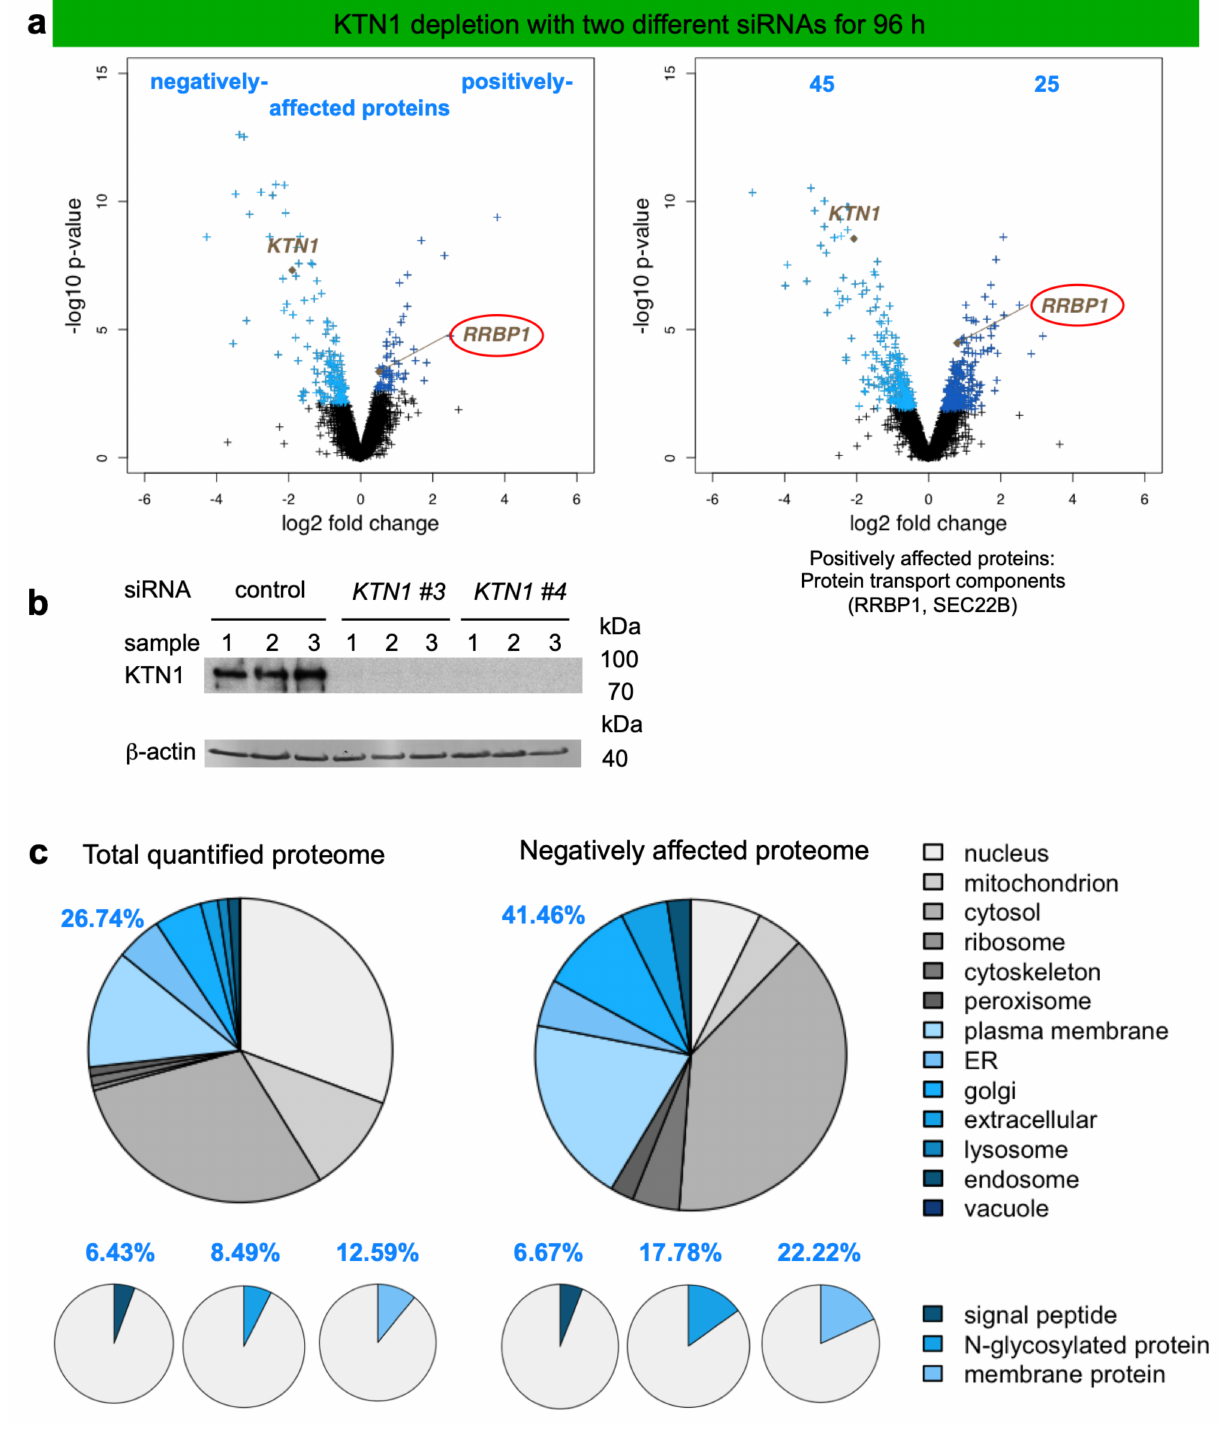
Figure 6. Volcano plots and GO enrichment after KTN1 depletion. ( a ) Differentially affected proteins were characterized by the mean difference of their intensities plotted against the respective permutation false discovery rate-adjusted p -values in volcano plots. The results for a single targeting siRNA are shown in each panel. KTN1 and RRBP1 are highlighted in the plots. The numbers of proteins, which were negatively or positively affected by both targeting siRNAs, are given in the right panel; the full set of relevant positively affected proteins are given below the right plot. ( b ) Knock-down efficiencies were evaluated by western blot. Results are presented as described in the legend to Figure 5. ( c ) Classification of KTN1 clients was based on GO enrichment factors as described in the legend to Figure